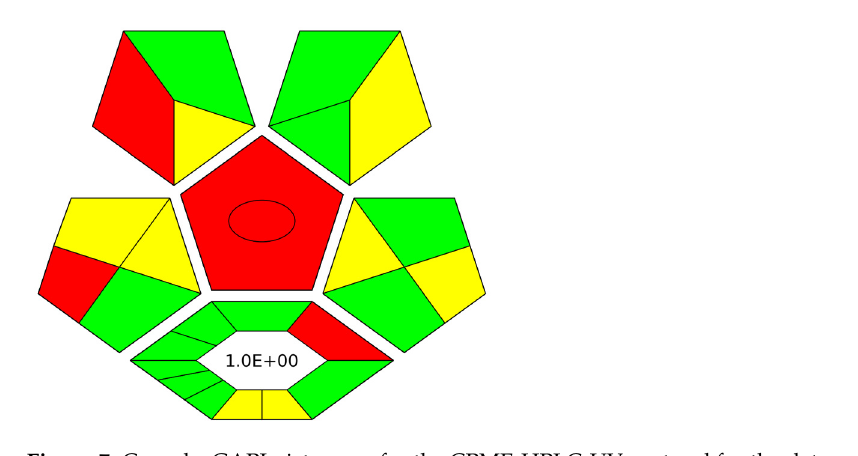
Figure 7. ComplexGAPI pictogram for the CPME-HPLC-UV protocol for the determination of AMB in human serum.